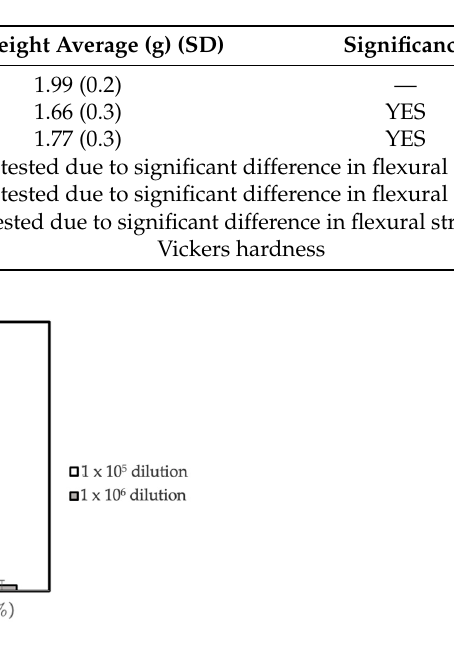
Figure 4. Biofilm formation on self-cure PMMA with various Gantrez concentrations ( n = 4) . Table 4. Biomass (dry weight) averages for various concentrations of self-cure Gantrez.